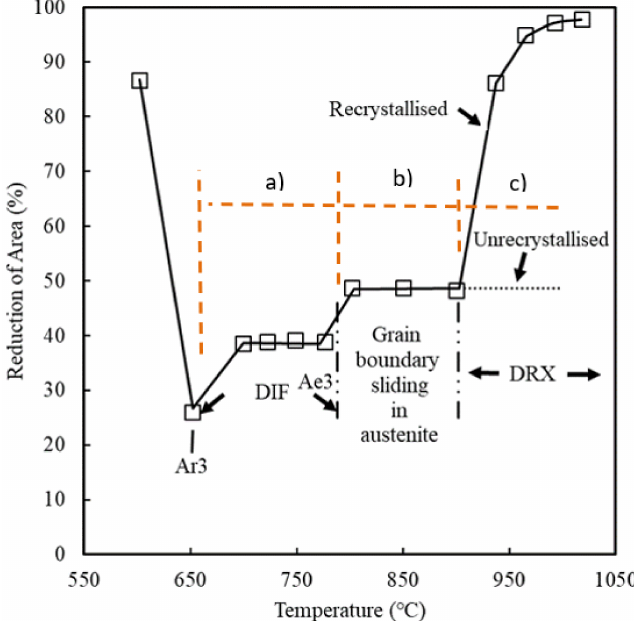
Figure 6. Hot ductility curve for a 0.4% C plain C-Mn steel tested at strain rate of 3 × 10 − 4 s − 1 having no micro-alloying precipitates present showing all the different regions that are possible in the trough on cooling down through the austenitic temperature range, region (a) Deformation Induced ferrite (DIF) between Ae3 (the transformation temperature below which ferrite first starts to form under equilibrium conditions) and the Ar3 (the transformation temperature below which the steel first starts to form ferrite under non equilibrium conditions of cooling), region (b) Un-recrystallised γ , region (c) Recrystallised γ